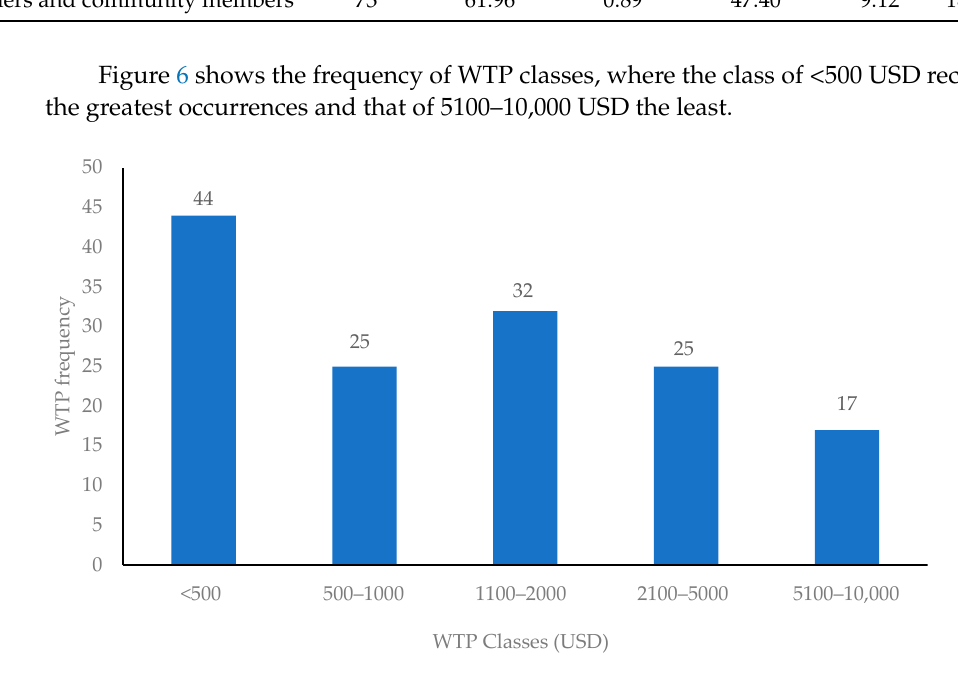
The ordered logistic regression results for WTP predictors of swampy wetland sus- tainability are shown in Table 4–6. Table 4 shows model A (with all predictors), Table 5 is a nested model B, and Table 6 is a nested model C (with limited predictors). Model A with all the predictors appears to have a better fit than the nested models do (shown in the tables). Table 4. Results of ordered logistic regression on determinants of the WTP model A. WTP